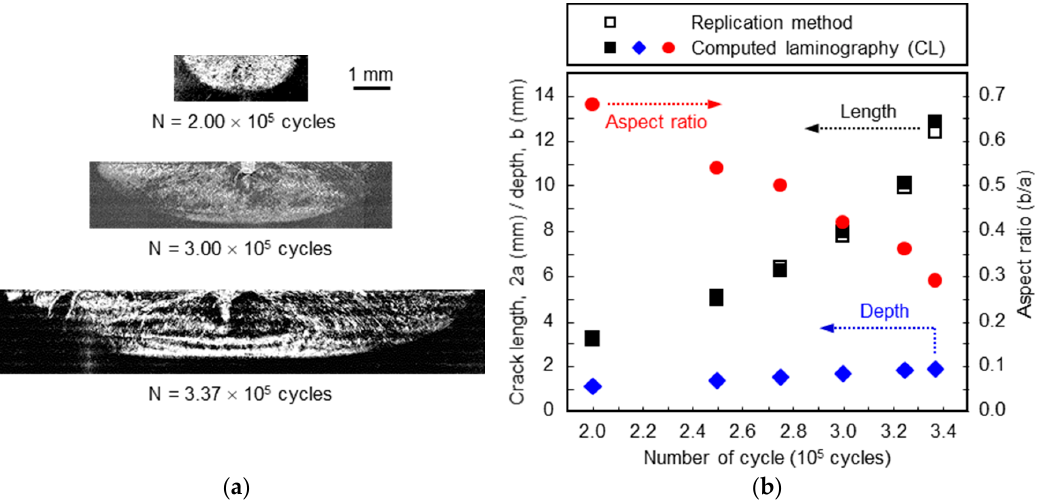
Figure 14. Crack propagation behavior: ( a ) Images of the main crack viewed from the fatigue loading direction; ( b ) crack propagation curves. The arrows point to the reference